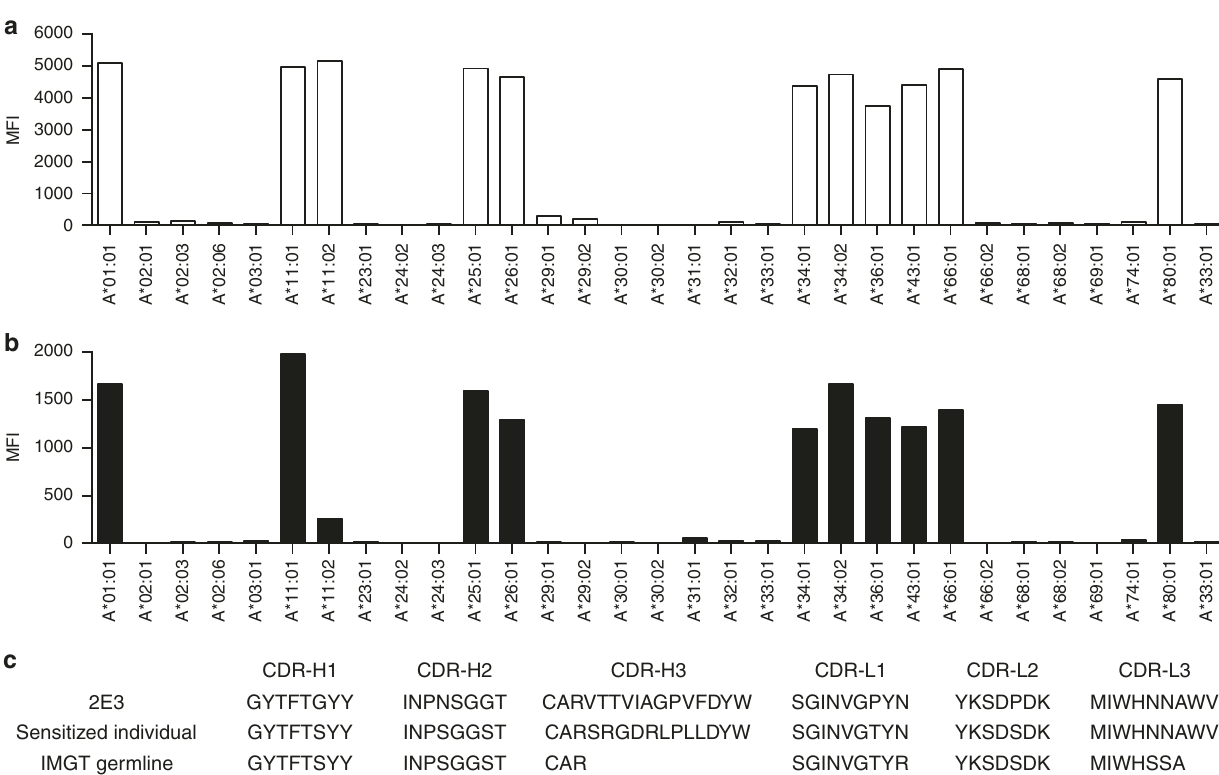
A functional comparison of IgG alloantibody subclasses . Alloantibody 2E3 was engineered into the four principal human IgG subclasses while retaining the antibody variable region sequence plus the binding speci fi city for HLA-A*11:01 (Fig. 4a). IgG3 has a larger heavy chain of 60 kDa than the other three IgG subclasses due to its longer hinge region (Fig. 4b). The reactive alleles of IgG2, IgG3 and IgG4 subclasses of 2E3 were veri fi ed to be the same as the IgG1 counterpart by ELISA binding to refolded recombinant monomers (Fig. 4c). The CDC and ADCC of the four subclasses were compared using A*11:01 homozygous EBV- BCLs as targets. Both IgG1, IgG2 and IgG3 subclasses of 2E3 induced signi fi cant levels of CDC of target cells at a relatively low